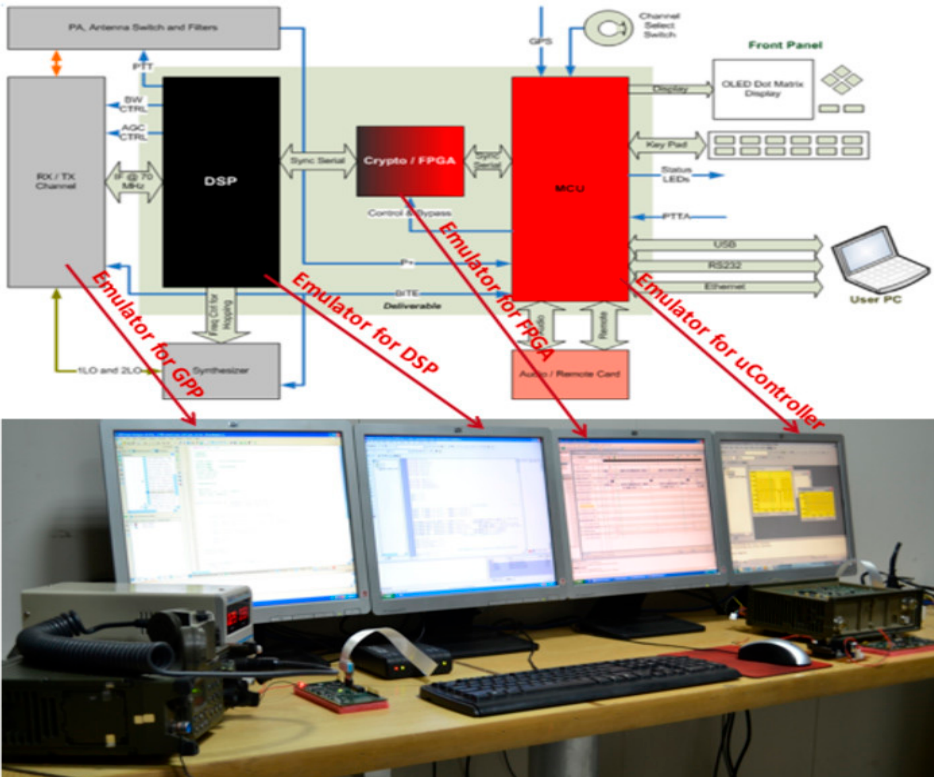
Figure 9. Emulators with multi interfaces.